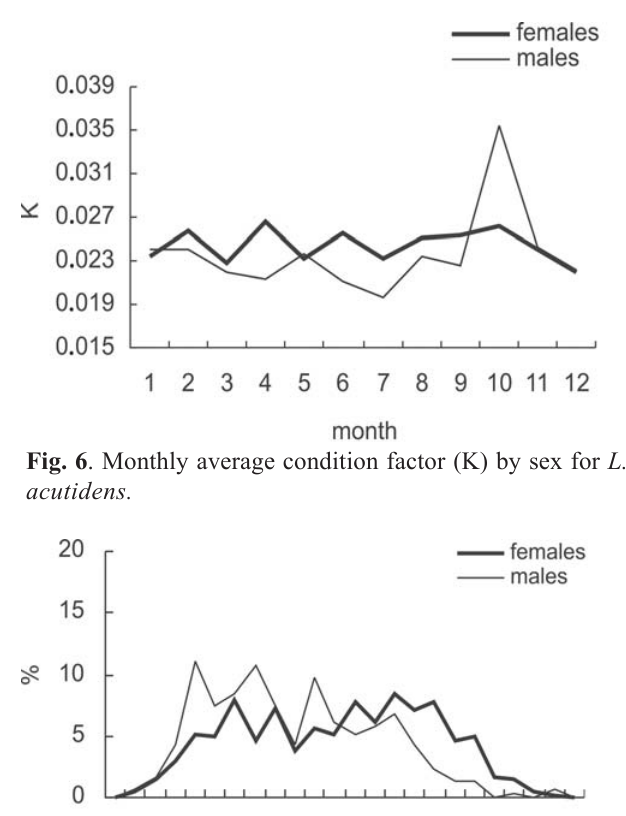
Fig. 5 . Relationship of the condition factor ( K ) by standard length class and sex for L. acutidens